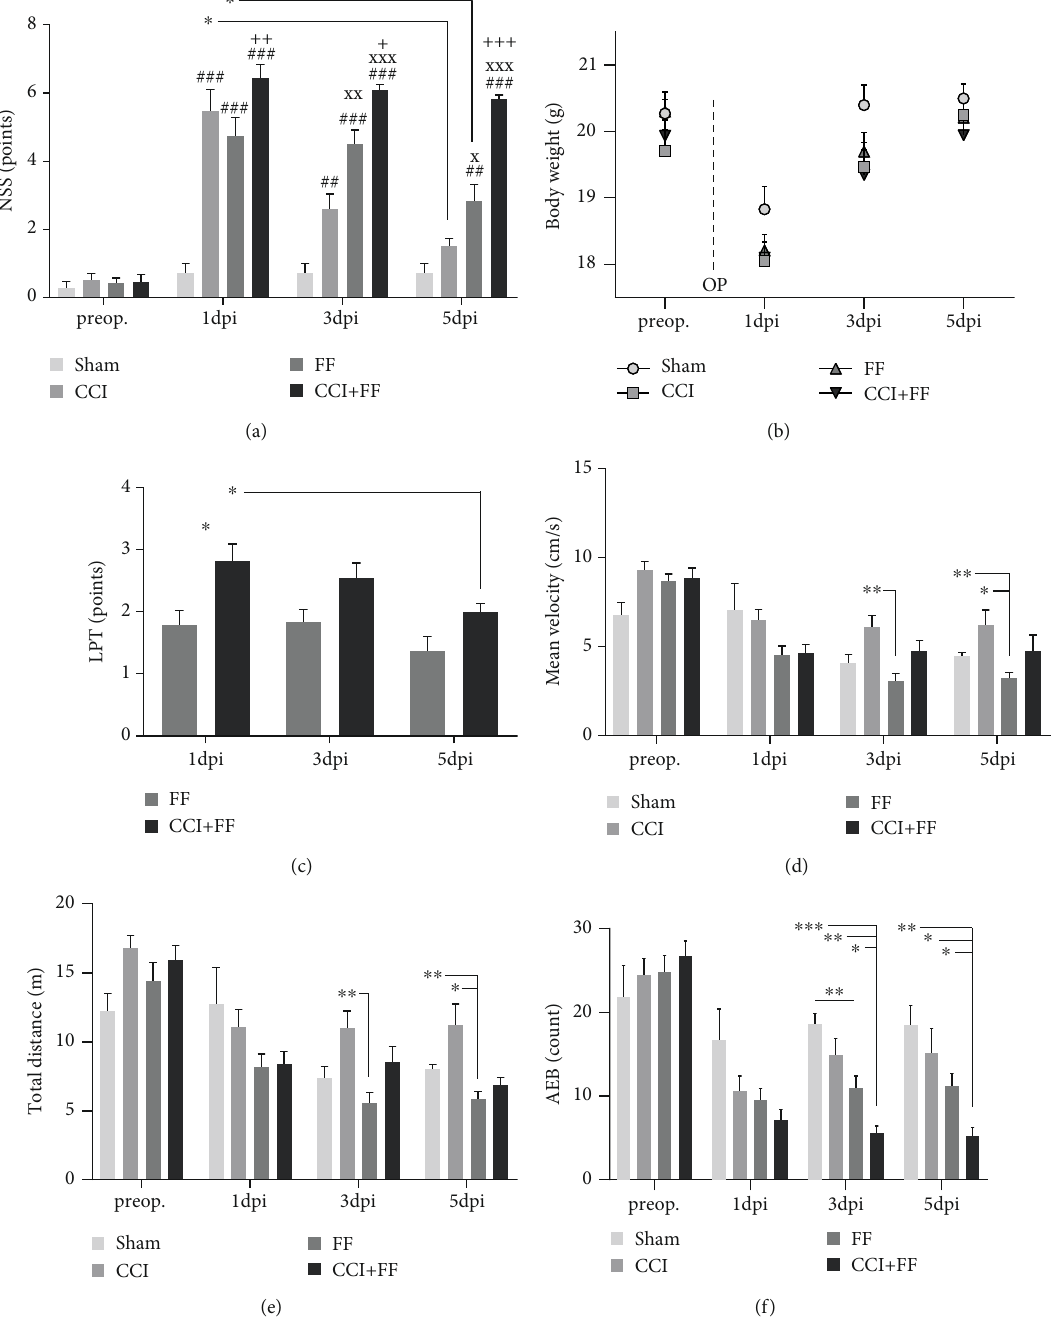
Figure 1: Femoral fracture impairs behavioral outcome after TBI. (a) NSS one day before as well as 1, 3, and 5dpi. CCI mice showed an increased NSS compared to sham at 1 and 3dpi and almost completely recovered until 5 dpi. Animals with FF demonstrated greater impairments in relation to sham up to 5dpi and recovered from 1 to 5 dpi. CCI+FF mice showed an increased NSS from 1 to 5 dpi and did not recover over time. Signi fi cance indicators: # signi fi cant compared to sham, + signi fi cant compared to FF, x signi fi cant compared to CCI, ∗ signi fi cant recovery from 1dpi to 5dpi. (b) Body weight one day before operation (preop.) and 1, 3, and 5dpi was not signi fi cantly altered between the groups. (c) Leg performance test (LPT), performed at 1, 3, and 5dpi in the FF and CCI+FF groups. CCI+FF mice showed higher scores at 1 dpi and recovered from 1 to 5 dpi. (d, e) Mean velocity and total distance in the OFT one day before and 1, 3, and 5dpi. FF mice showed less locomotion in comparison to CCI 3 dpi and CCI and sham 5dpi. CCI+FF mice did not di ff er from other experimental groups. (f) Anxiety expression behavior (AEB) one day before and 1, 3, and 5dpi. CCI+FF mice showed reduced AEB compared to all other groups at 3 and 5 dpi. Values of all data represent mean ± SEM ; p values were calculated dependent on data distribution by Tukey ’ s multiple comparison test (a, d, e) or Holm-Sidak ’ s multiple comparison test (b, c,